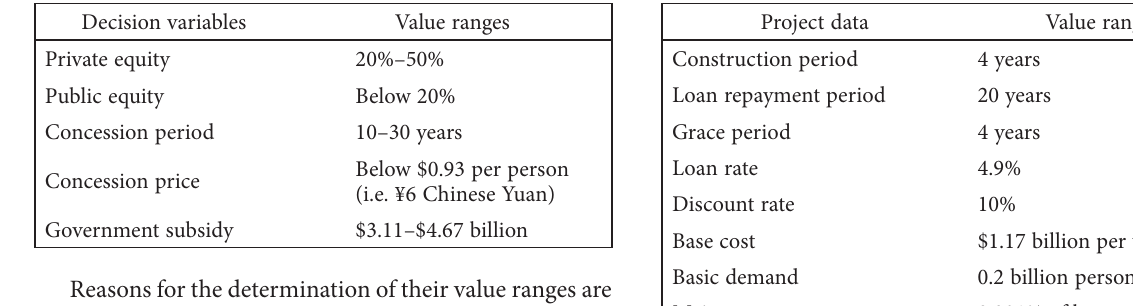
Table 2. Decision variables and value ranges Table 3. Project data and value ranges